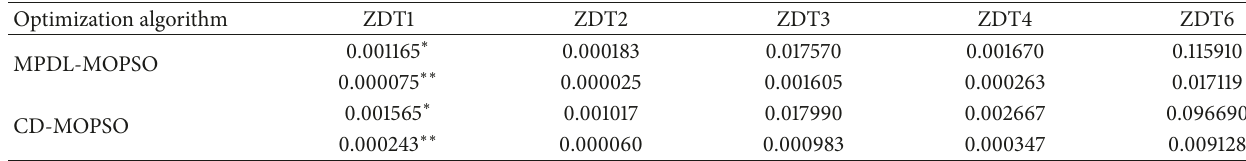
Table 2: GD results of optimal solutions for every problem.